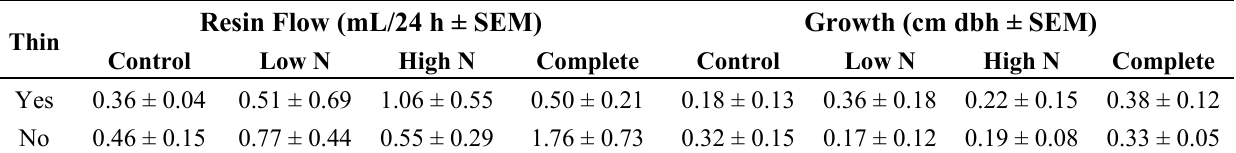
Table 2. Resin flow (mL/24 h ± SEM) and growth (cm dbh ± SEM) of lodgepole pines the summer following treatment (thinning and fertilization of individual trees with N at